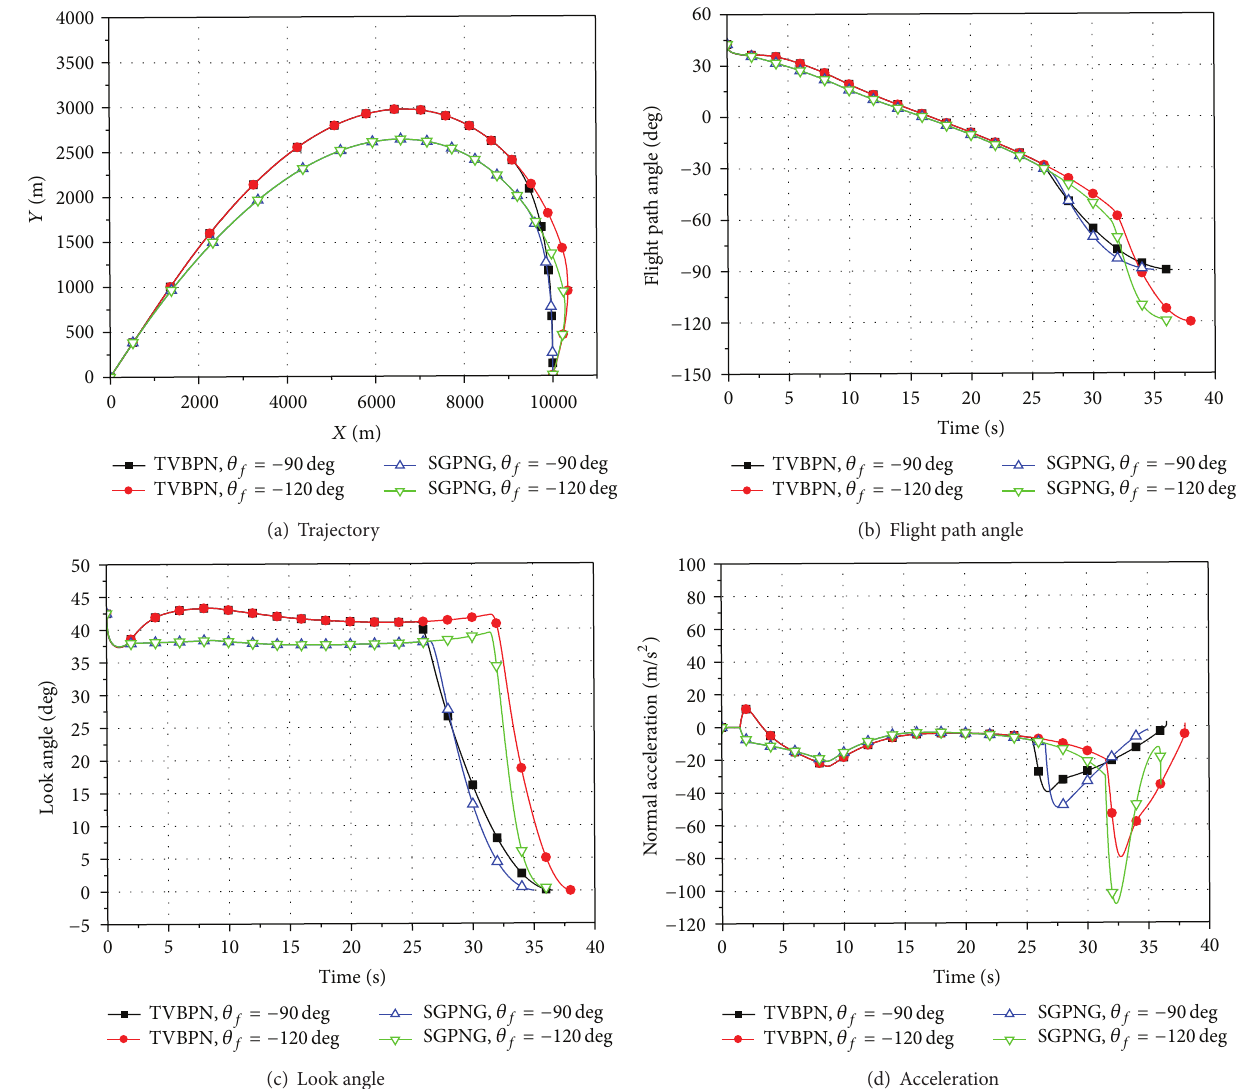
Figure 6: Comparison results for realistic missile model.